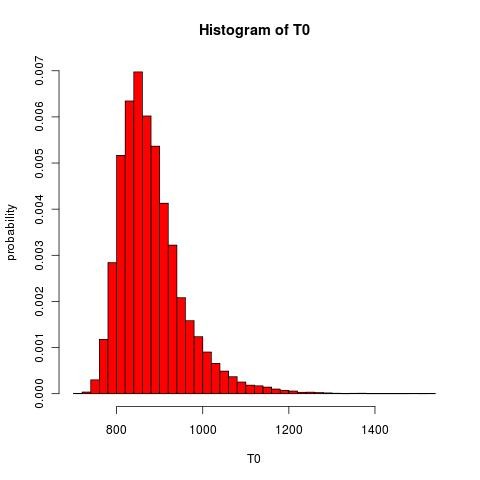
Histogram of null distribution.